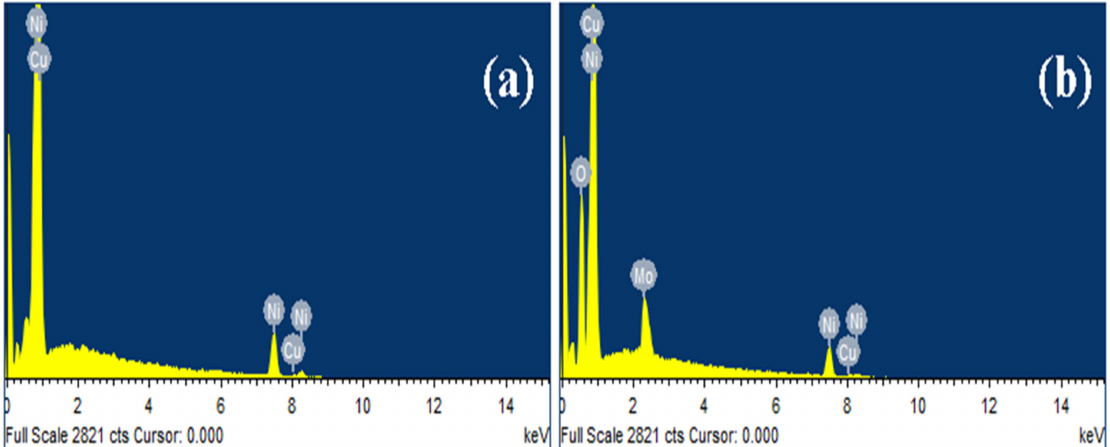
Figure 5. EDS spectra of ( a ) Cu-Ni bi-layer substrate and ( b ) Cu/Ni/MoO 3